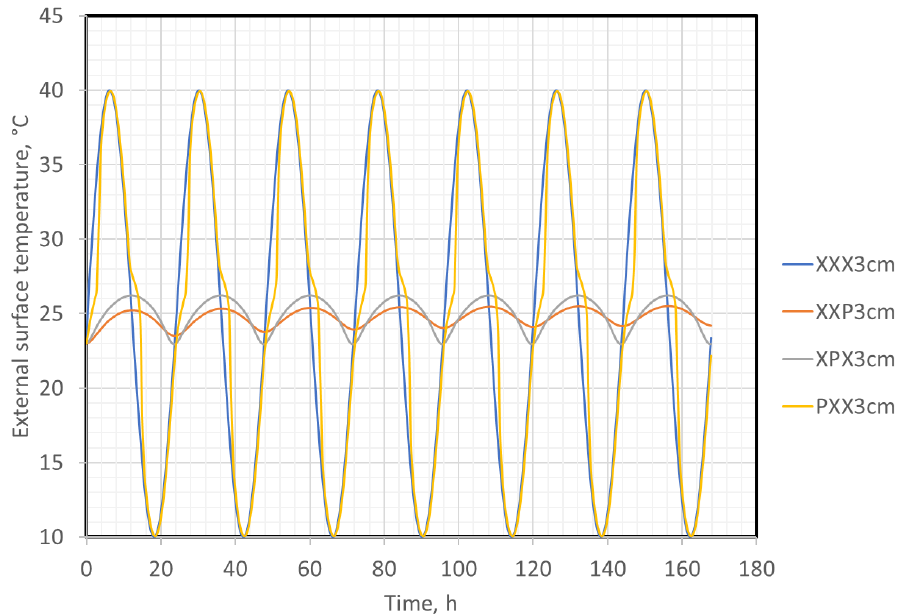
Figure 17. The internal surface temperature variation of a wall configuration of three layers. P stands for PCM; X stands for XPS; the number behind stands for the entire wall thickness.